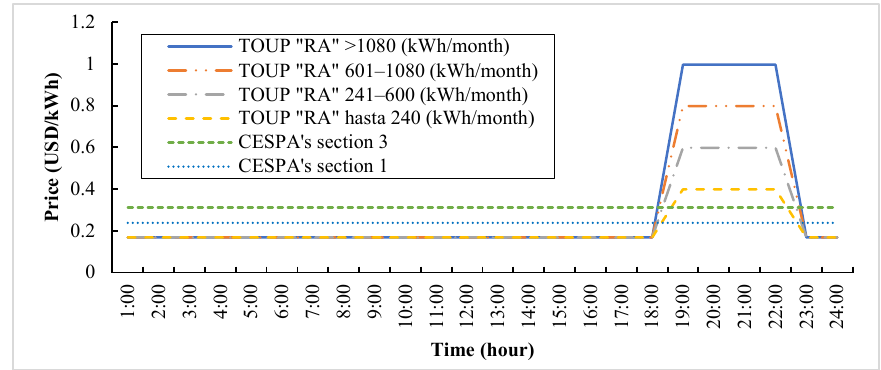
Figure 5. TOUP Residential A option vs. sections of CESPA in February 2020 trends.